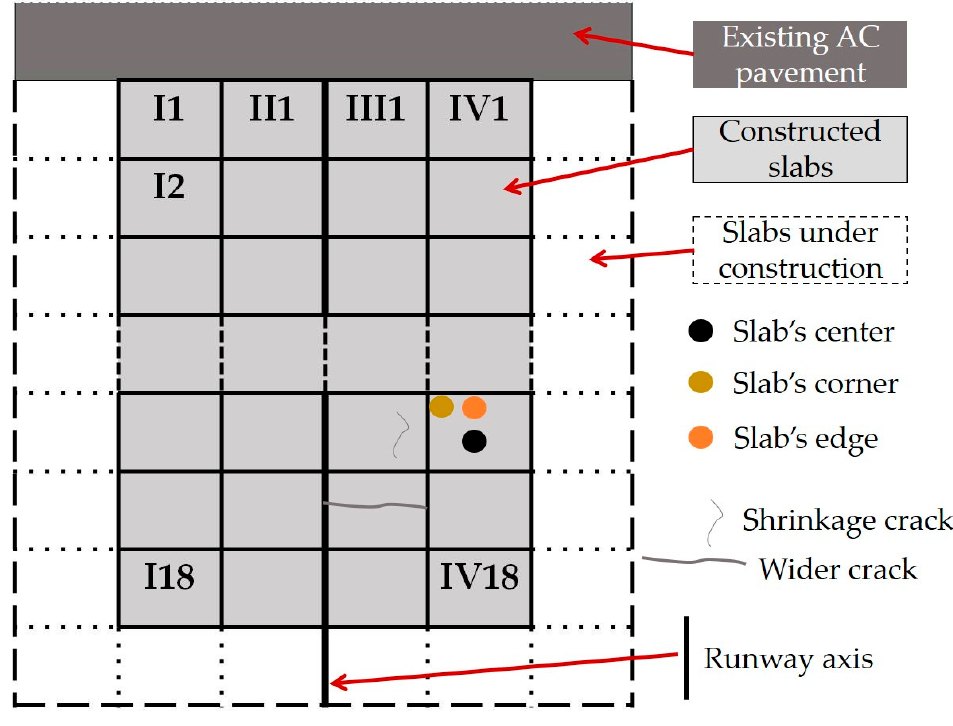
Figure 8. Survey scheme.